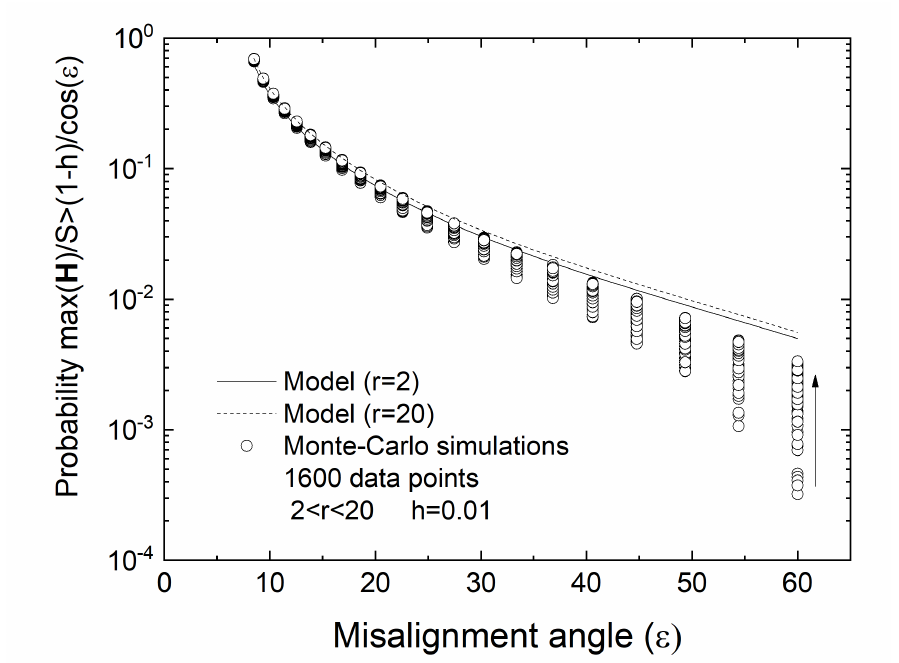
Figure 6. The probability of achieving intersection lengths that satisfy Equation (7) at the 1% level ( h = 0.01), as a function of the misalignment angle (cid:101) . Lines show the predictions of Equation (9) for two values of r . Points are results of MC simulations, using 2 × 10 5 random pairs of ( L , θ ) and 5 repetitions at each level of r and (cid:101) . Since it must be cos (cid:101) / ( 1 − h ) < 1 in Equation (9), it follows that for h = 0.01 that allowable values of (cid:101) are (cid:101) > 8.1 ◦ . The vertical arrow next to the column of the MC data at (cid:101) = 60 ◦ indicates the direction of increasing the aspect ratio r (2 < r <